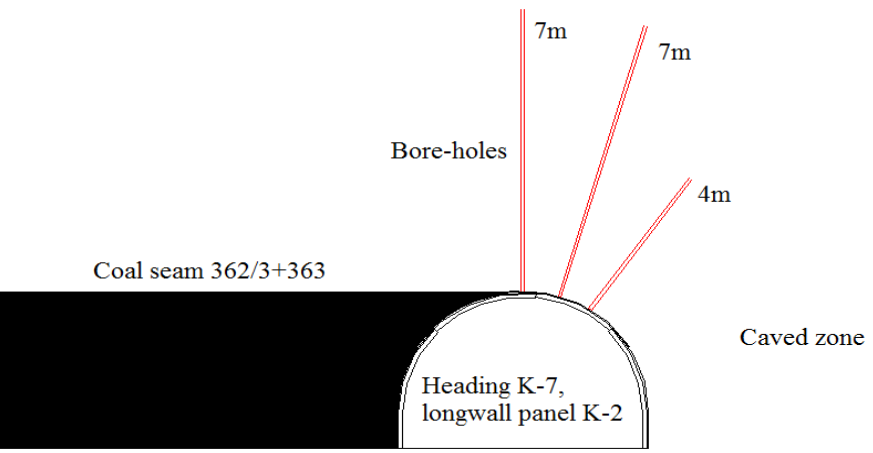
Figure 10. Diagram of test boreholes in the K-7 heading of the K-2 longwall panel. The results demonstrate that the rock mass was heavily fractured in all the boreholes (Figures 11–13). The estimated average spacing between fractures in the diagonal boreholes was about 5–10 cm, and about 1–3 cm in the vertical hole.